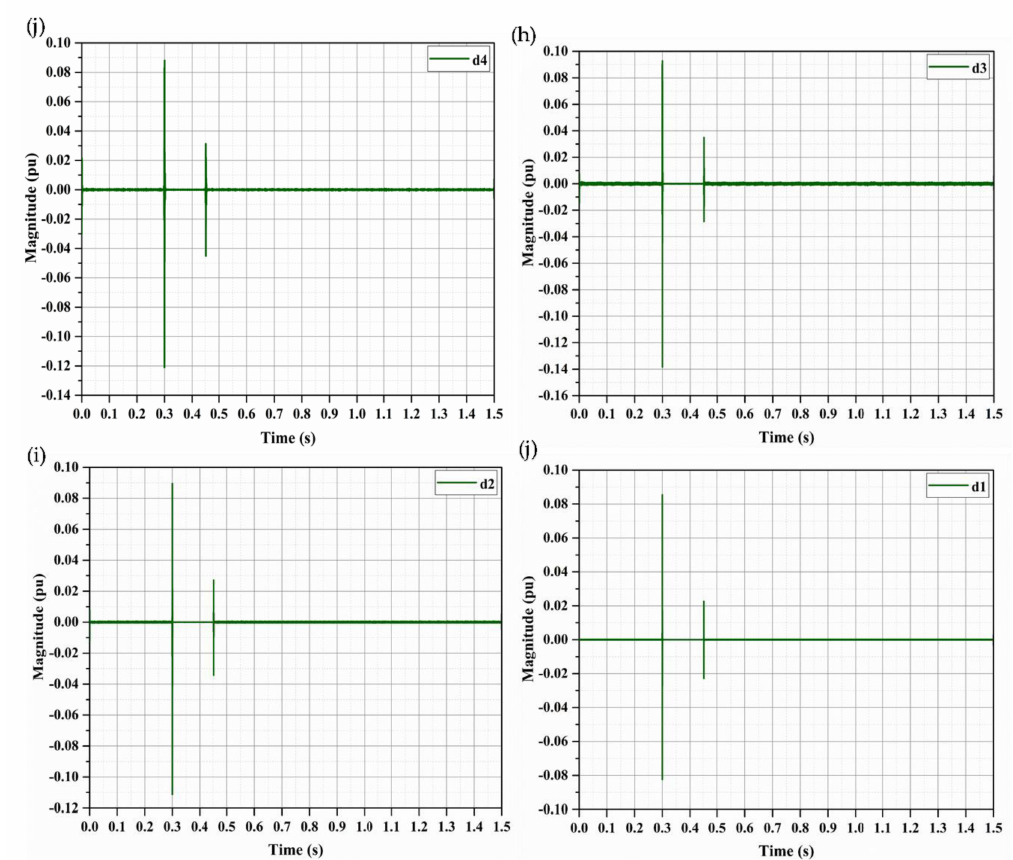
Figure 3. ( a – j ) Wavelet decomposition levels of the point of common coupling (PCC) voltage signal at phase A during three phase to ground (PPP-G) fault condition. Table 1. The entropy values of di ff erent fault types.